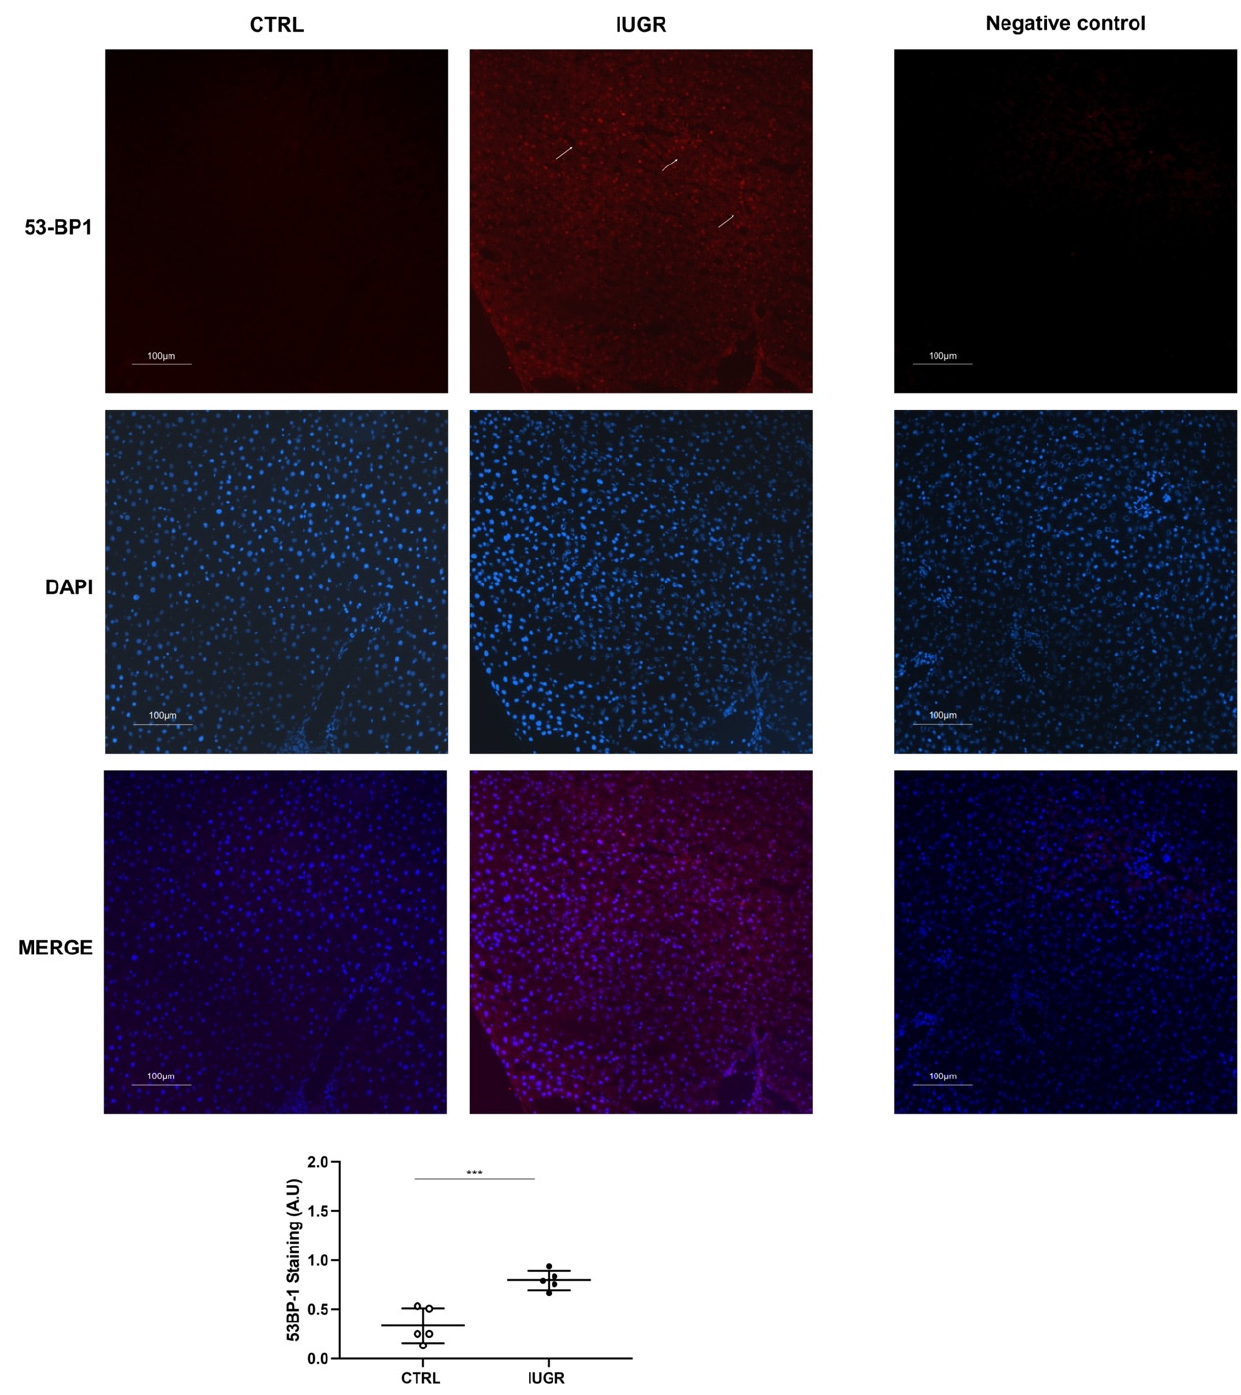
Figure 8. DNA double-strand breaks (arrows) were evaluated using 53BP-1 staining in the liver from CTRL and IUGR males. A negative control was established. Nuclei were counterstained with DAPI. n = 5 animals/group. *** p < 0.001. Magnification (20×). Scale bar = 100 µm.